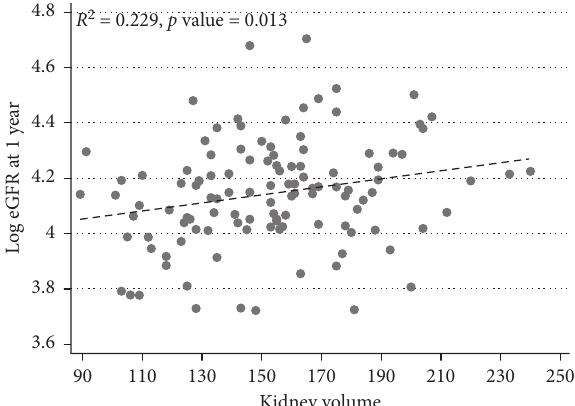
Figure 4: Correlation of kidney volume and eGFR in kidney donors at 1 year after donation.